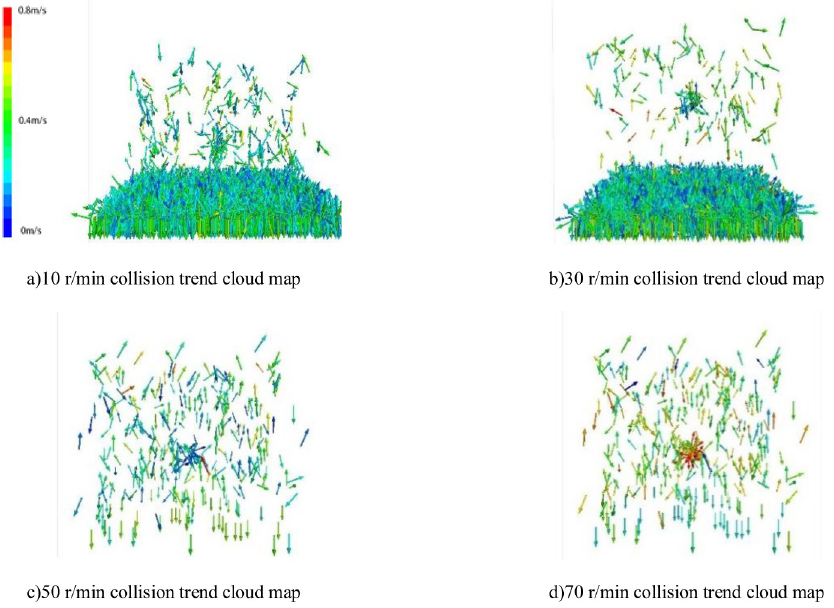
Fig 4. Collision trend cloud map under different disturbance conditions. a)10 r/min collision trend cloud map, b) 30 r/min collision trend cloud map, c)50 r/min collision trend cloud map, d)70 r/min collision trend cloud map.